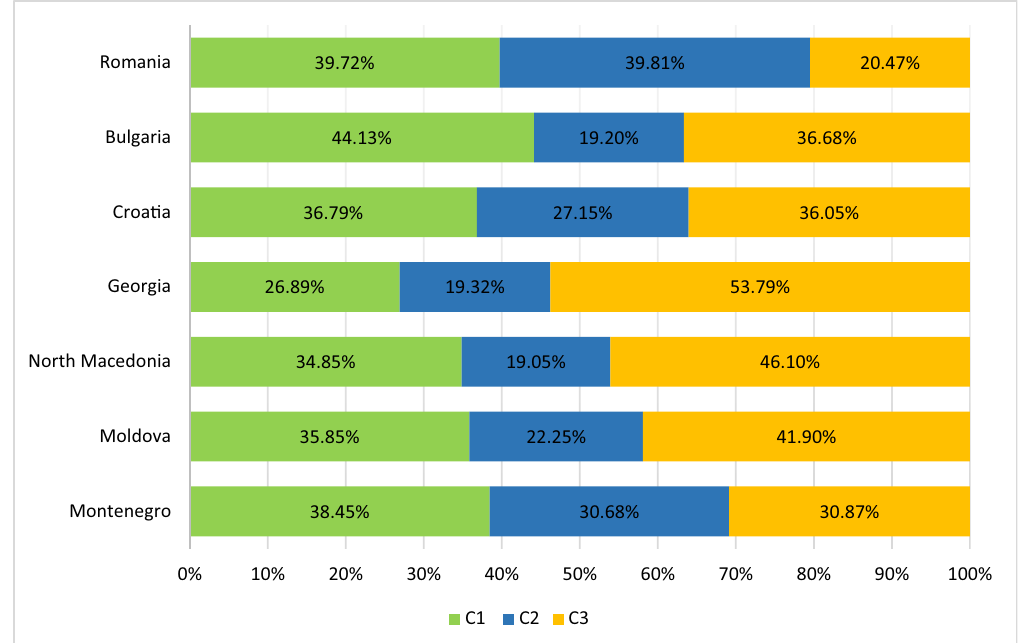
Figure 2: Respondents ’ distribution by clusters and countries. Source: Calculated by the authors based on OECD primary data ( 2019 )